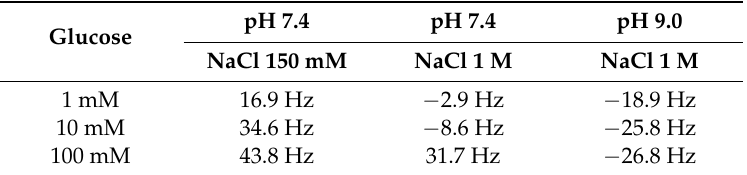
Table 1. The decomposition of PAH/GOx/(SA-PAH/PBA-PAH) 10 films after immersion for 60 min in glucose solutions.